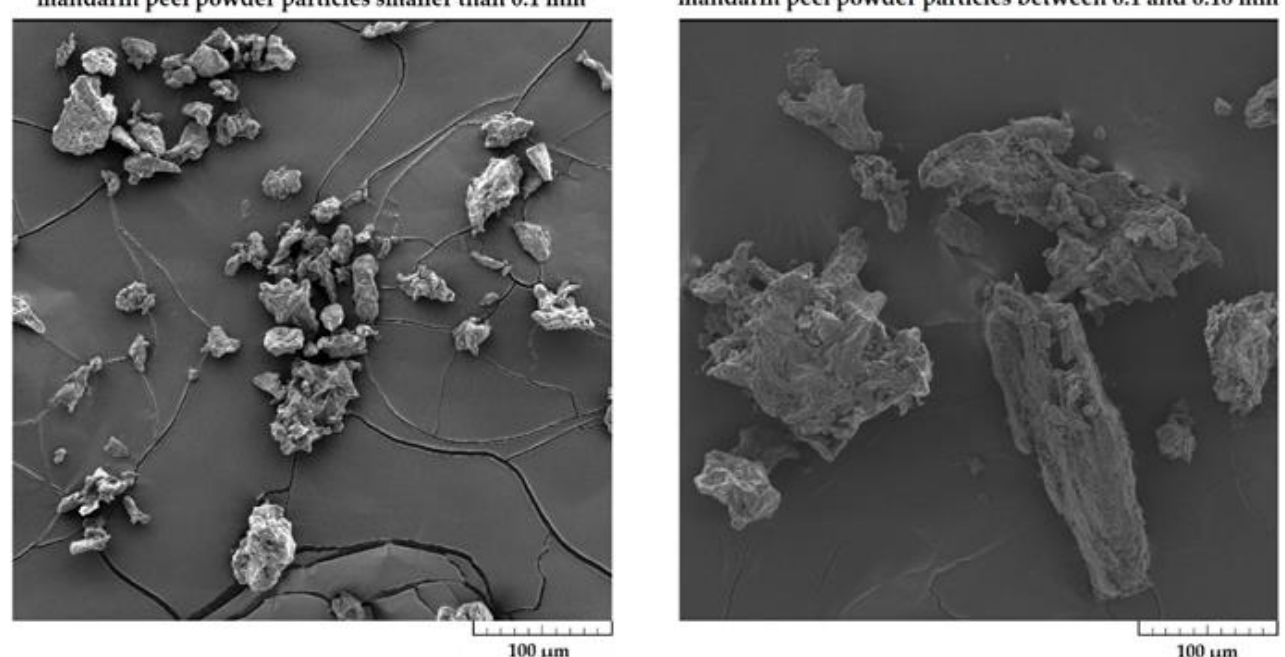
Figure 3. SEM images of MPP containing particles ( left ) less than 0.10 mm and ( right ) from 0.10 to 0.16 mm.